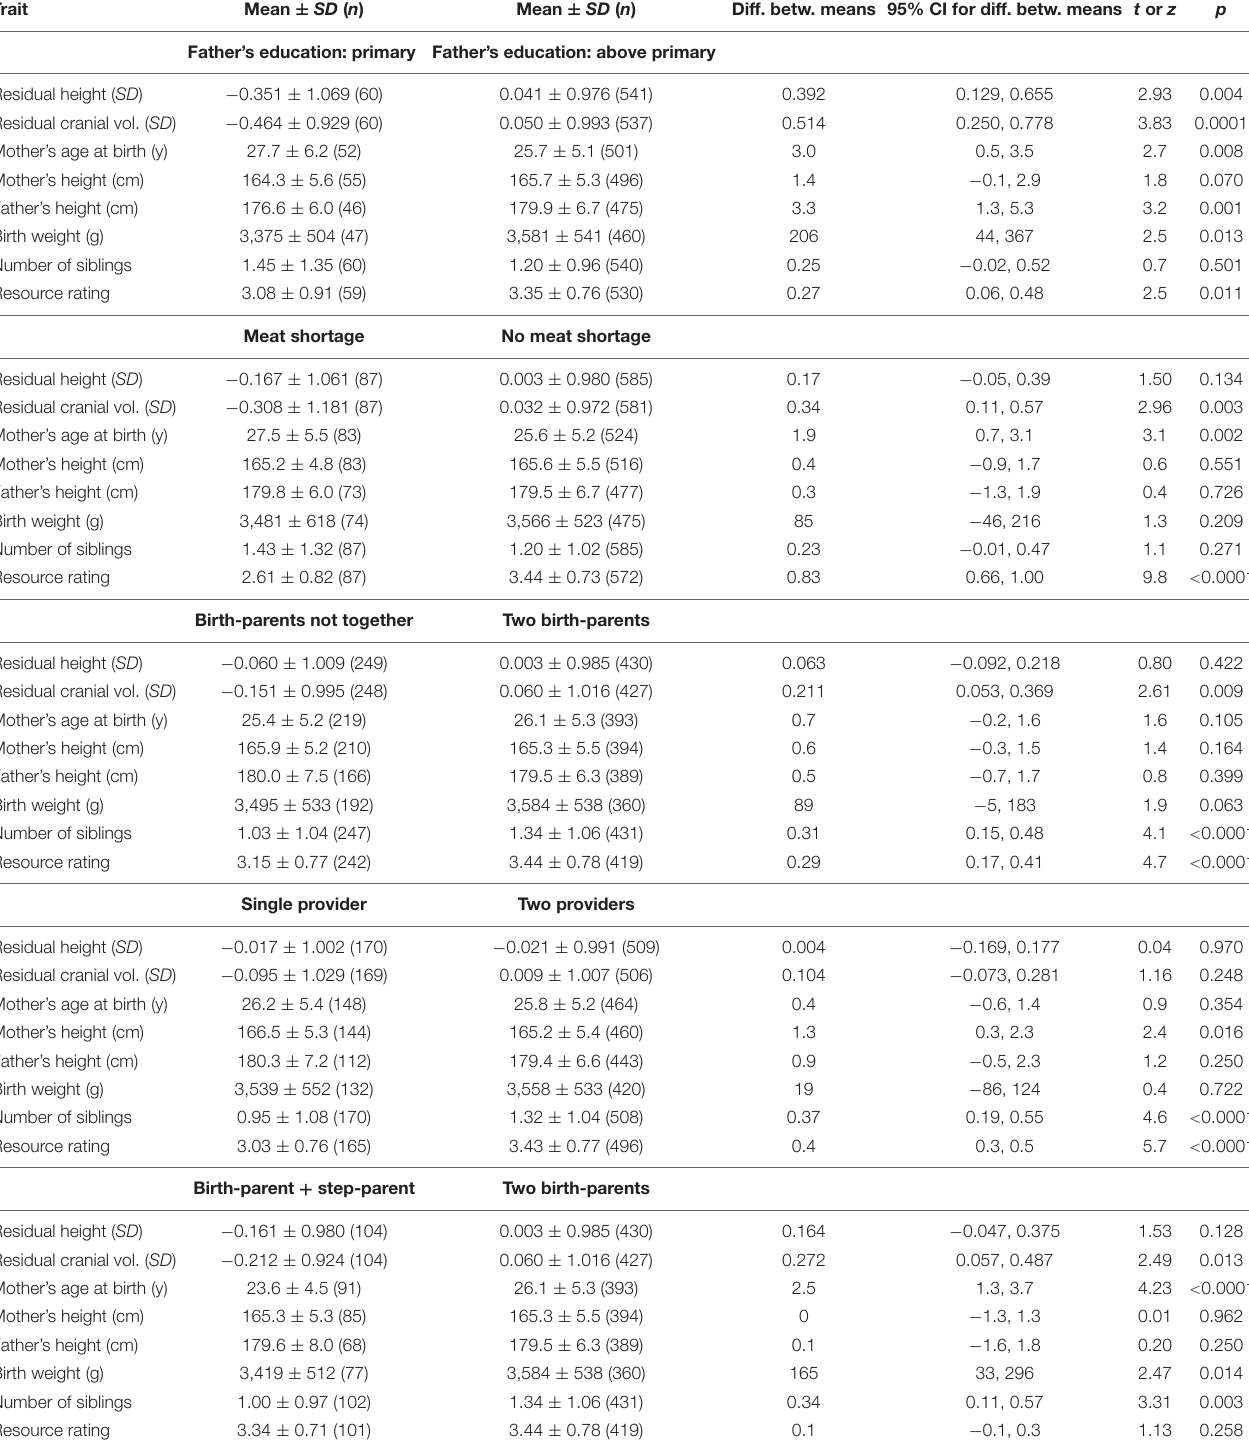
TABLE 1 | Associations between father’s education, meat shortage, and family type with morphometric and family traits of children and their parents. Trait Mean ± SD ( n ) Mean ± SD ( n ) Diff. betw. means 95% CI for diff. betw. means t or z